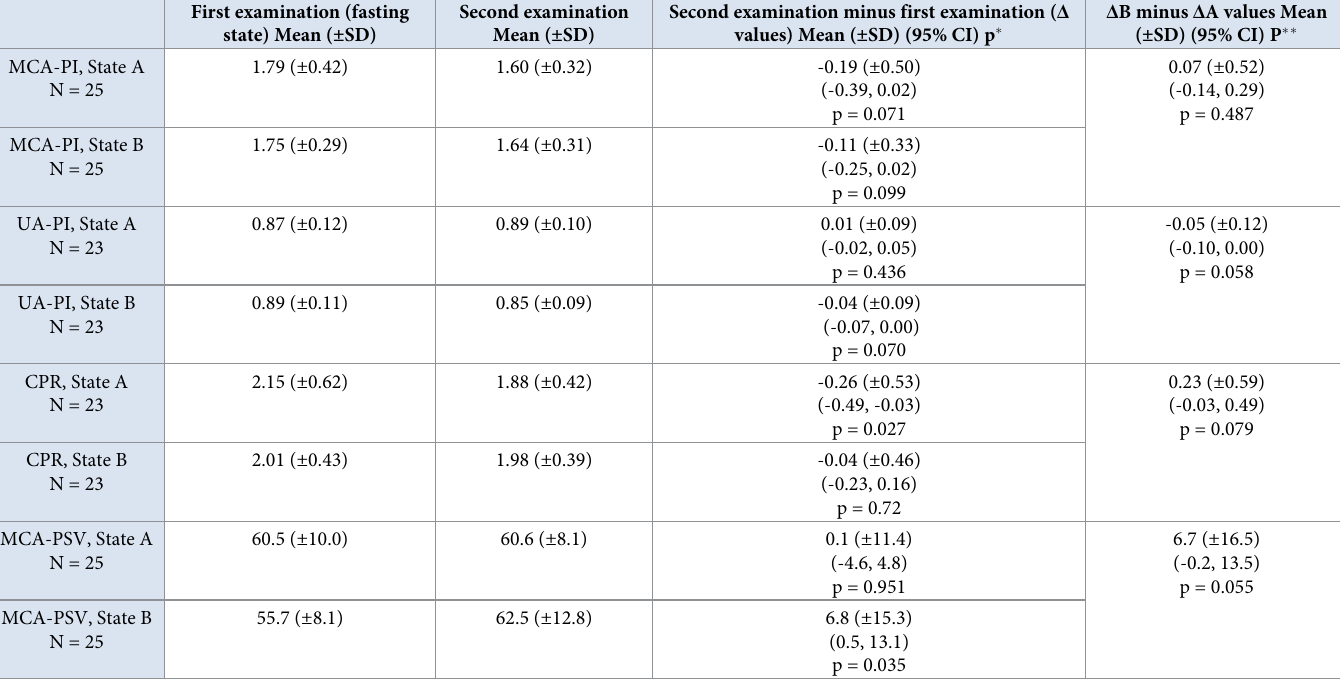
Table 2. Pulsatility indices in the middle cerebral artery and umbilical artery, the cerebroplacental ratio, and peak systolic velocity in the middle cerebral artery in the first and the second examination in state A and state B. First examination (fasting state) Mean ( ±